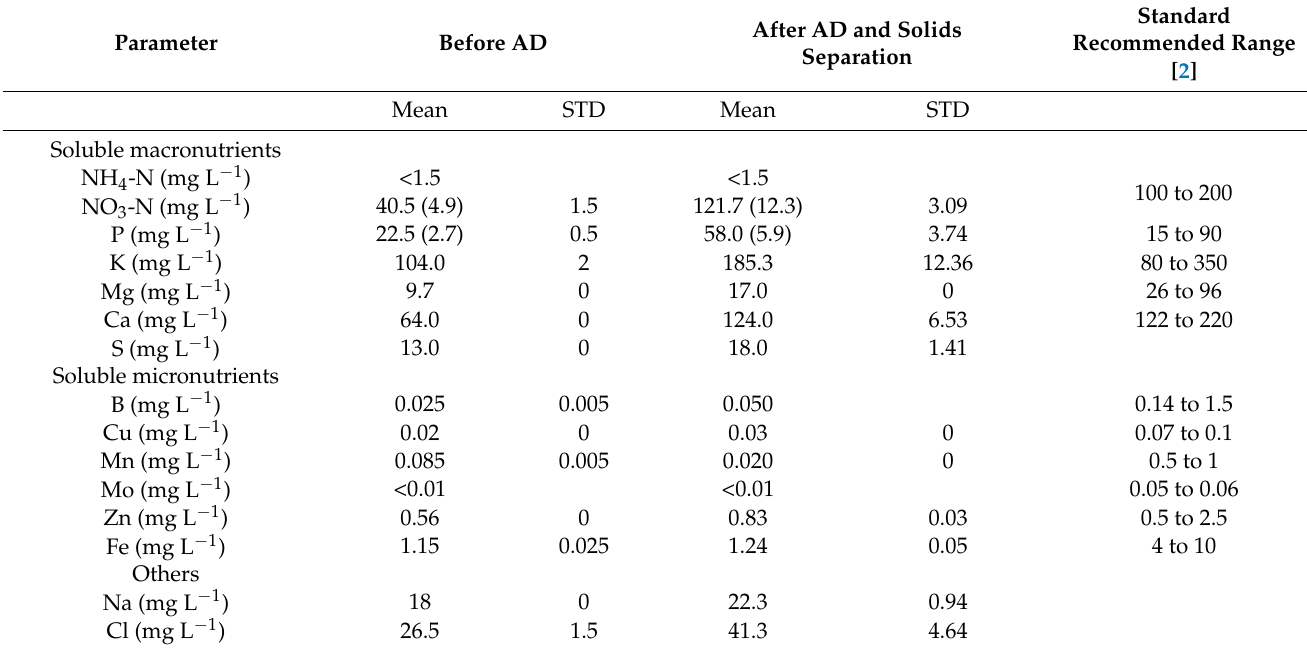
Table 2. Concentrations of soluble nutrients in the sludge before and after aerobic digestion. Mean values and standard deviations (STD) are given. Parameter Before AD